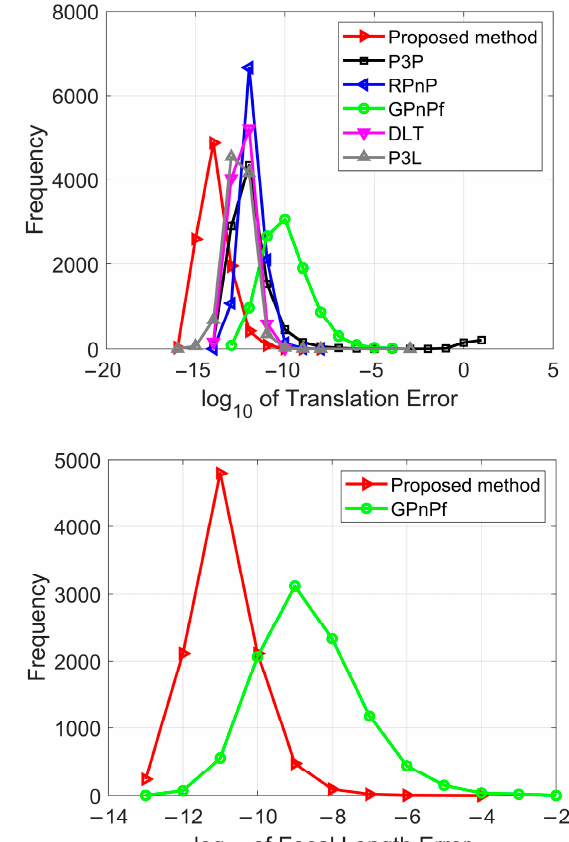
11 of 18 Figure 6. Robustness to camera position noise for the rotation error ( Top left ), translation error ( Top right ), reprojection error ( Bo tt om left ) and focal length error ( Bo tt om right ). In Figure 6, the rotation error and focal length error are both low, which can be re- garded as zero, even though error spikes exist. The reason is that the rotation and focal length estimation do not involve the camera position, which can be explained with Equa- tions (6) and (21). In addition, as the camera position noise increases, so do the translation and reprojection errors. The reason is that the translation estimation involves the camera position, which can be explained with Equation (21). For reprojection, it is related to rota- tion, focal length and translation; hence, it is a ff ected by the camera’s position. When the camera position noise is 3 cm, the translation and reprojection errors both reach the max- imums, which are 0.028 m and 0.26 pixels, respectively. The errors are both small and show that our proposed method has strong robustness to the camera position noise. 3.1.2. Numerical Stability We tested our proposed method in terms of numerical stability in this section. A total